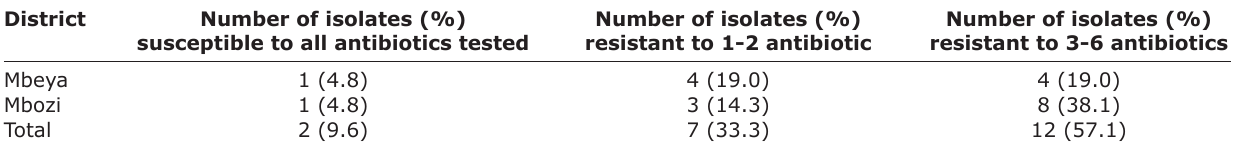
Table-3: Frequency distribution of antibiotic resistance of Staphylococcus aureus isolates from cows’ milk obtained from smallholder dairy farms in Mbeya and Mbozi districts, Tanzania (n=21). District Number of isolates (%) Number of isolates (%) susceptible to all antibiotics tested resistant to 1-2 antibiotic